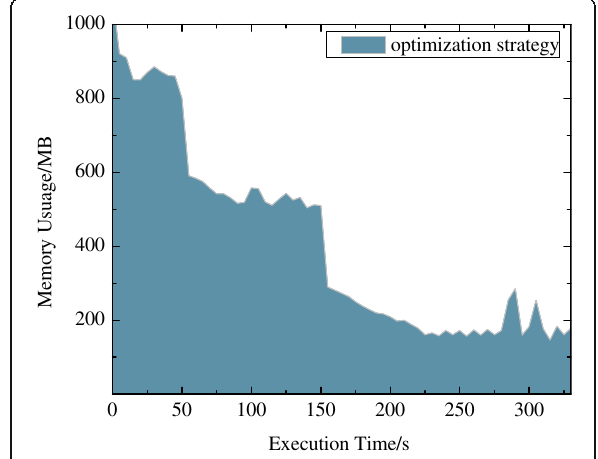
Fig. 3 The memory utilization of